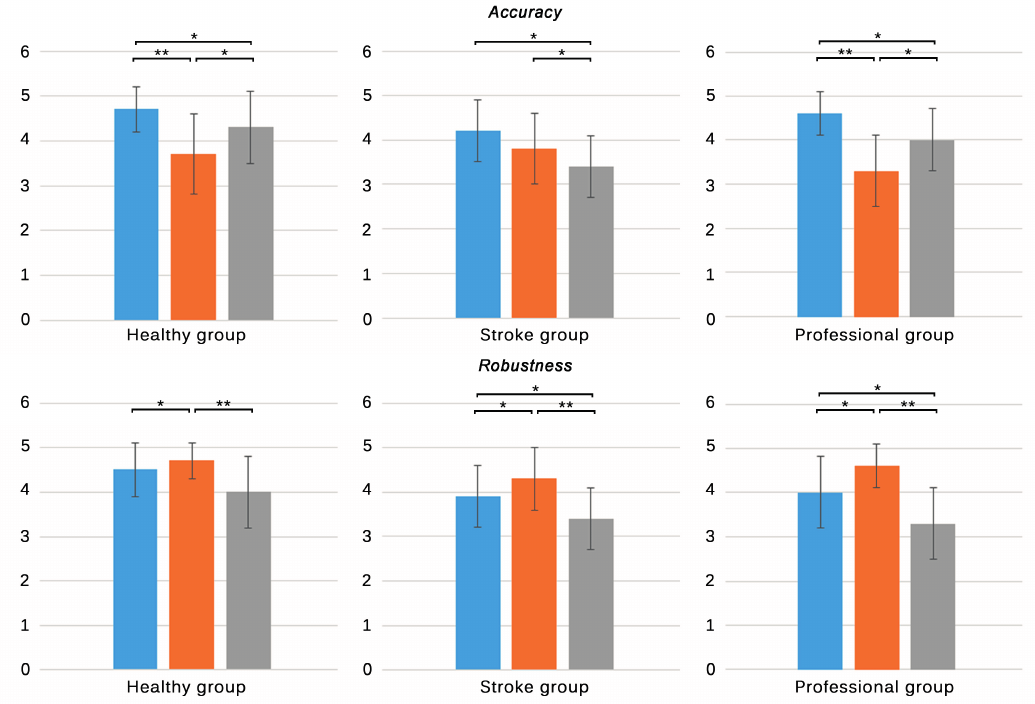
Figure 4. Subjective responses of all groups to the first four items of questionnaires A and B . Blue : NaturalPoint ® OptiTrack TM ; Orange : Polhemus TM G4 TM ; Grey : Microsoft ® Kinect TM . Only significant differences are stated. * p < 0.05, ** p < 0.001.